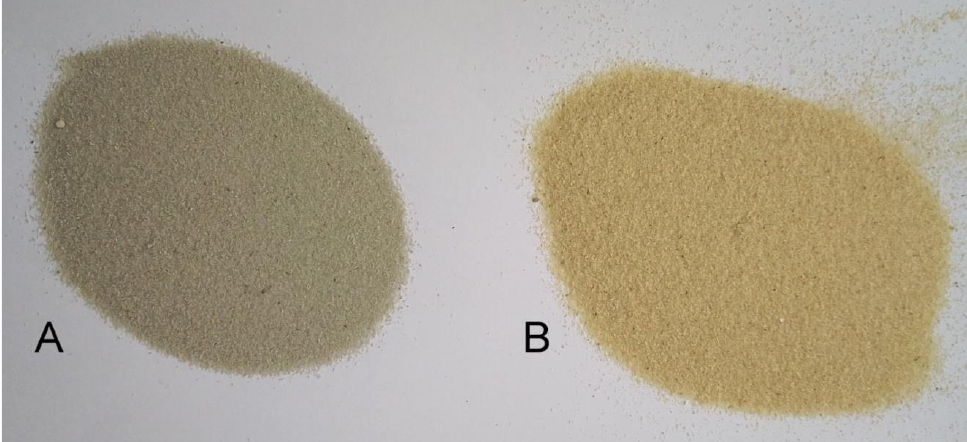
Fig. 1. Visual observation of bone powder showing the effect of milling on the colour: (A) Bovine bone changed to gray (B) Caprine bone remained